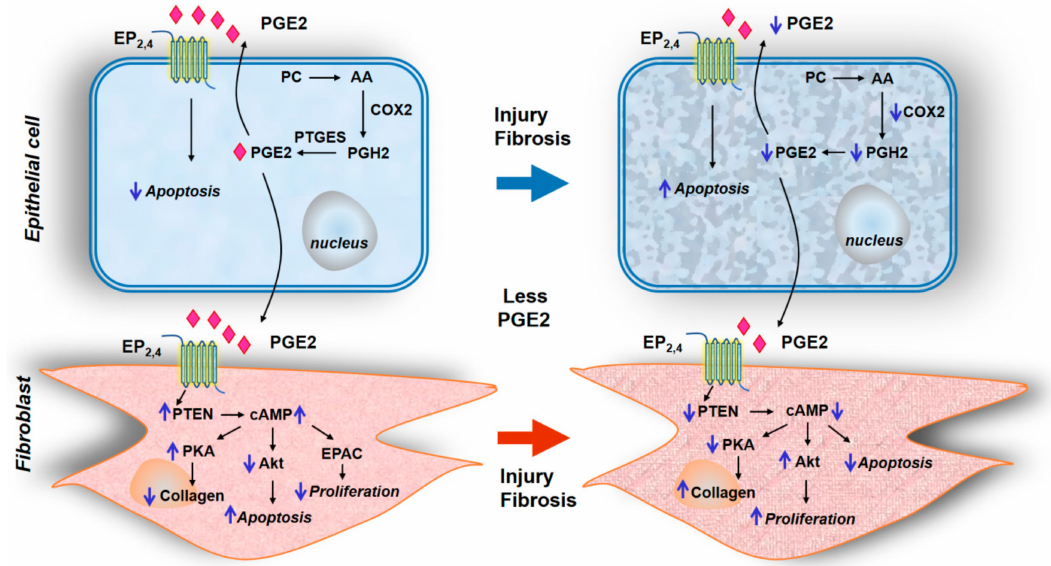
Figure 1. Prostaglandin E2 signaling via EP2 / EP4 in epithelial cells and fibroblasts for the development of pulmonary fibrosis. Schema depicts PGE2 biosynthesis from arachidonic acid by COX2 and prostaglandin E synthases in alveolar epithelial cells. The autacoid function of PGE2 via its receptors EP2 and EP4 regulates homeostatic signaling between the alveolar epithelial cells (AECs) and pulmonary fibroblasts. Fibrotic signaling is specified by enhanced apoptosis and diminished secretion of PGE2 by AECs due to injury, which in turn promotes fibroblast proliferation, collagen deposition, and myofibroblast di ff erentiation, distinct in pulmonary fibrosis. AA—Arachidonic acid, cAMP—cyclic adenosine monophosphate, COX2—Cyclooxygenase-2, EP 2,4 —Prostaglandin EP 2 ,EP 4 receptor, EPAC—Exchange protein directly activated by cAMP, PC—Phosphatidyl